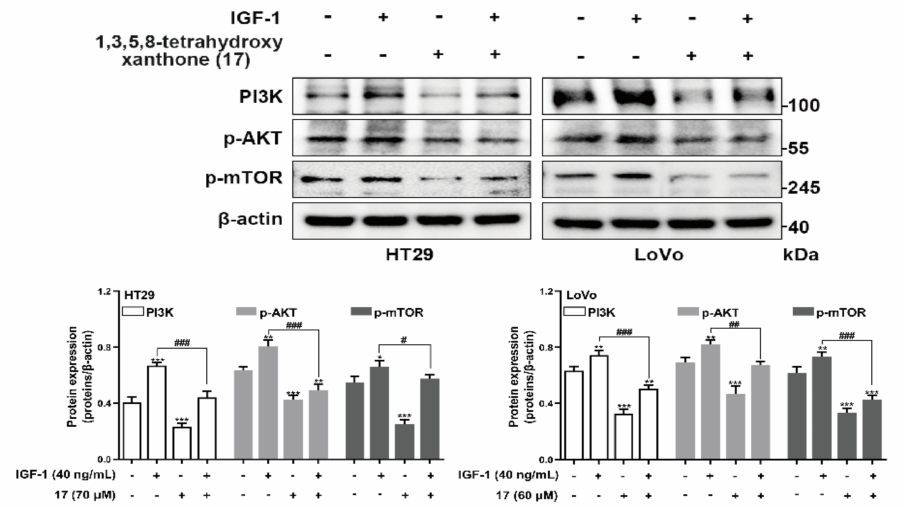
Figure 8. Western blot verification of 1,3,5,8 − tetrahydroxyanthrone ( 17 ) intervening CRC by PI3K/Akt/mTOR signaling pathway. CRC cells were treated with IGF − 1 (40 ng/mL) for 24 h, 1,3,5,8 − tetrahydroxyxanthone ( 17 ) was treated with 70 µ M for HT29 cells and 60 µ M for LoVo cells. Expression and statistics of PI3K, p − Akt (Ser473), p − mTOR (Ser2448) proteins detected after treat- ment of HT29 and LoVo cells with compound 17 . Data are presented as the means ± SEM, * p < 0.05, ** p < 0.01, *** p < 0.001 (Differences between compound-treated group, IGF − 1-treated group, as well as (compound + IGF − 1)-treated group and control group). # p < 0.05, ## p < 0.01, ### p <